Question: What form of chart is displayed?
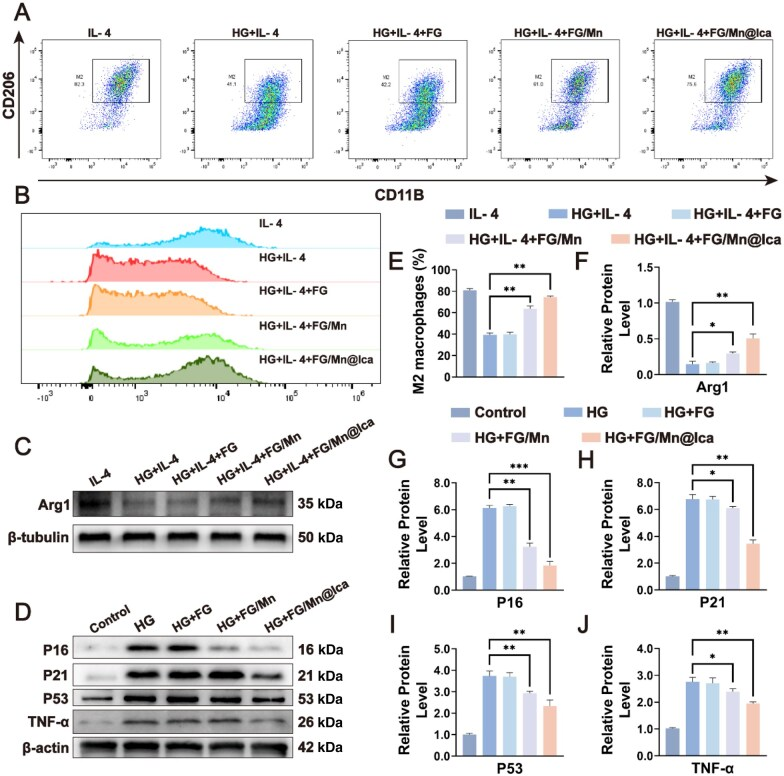
Answer: histogram